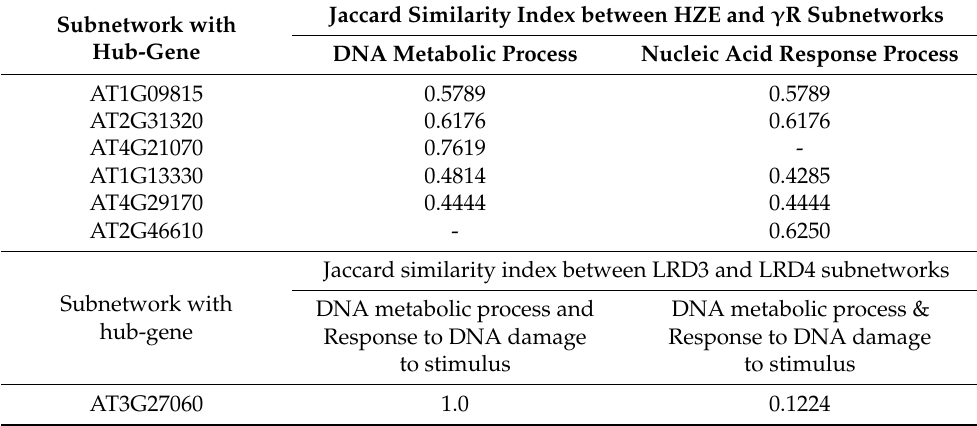
Table 7. Jaccard similarity index between subnetworks for different levels of radiation doses. Jaccard Similarity Index between HZE and γ R Subnetworks Subnetwork with Hub-Gene DNA Metabolic Process Nucleic Acid Response